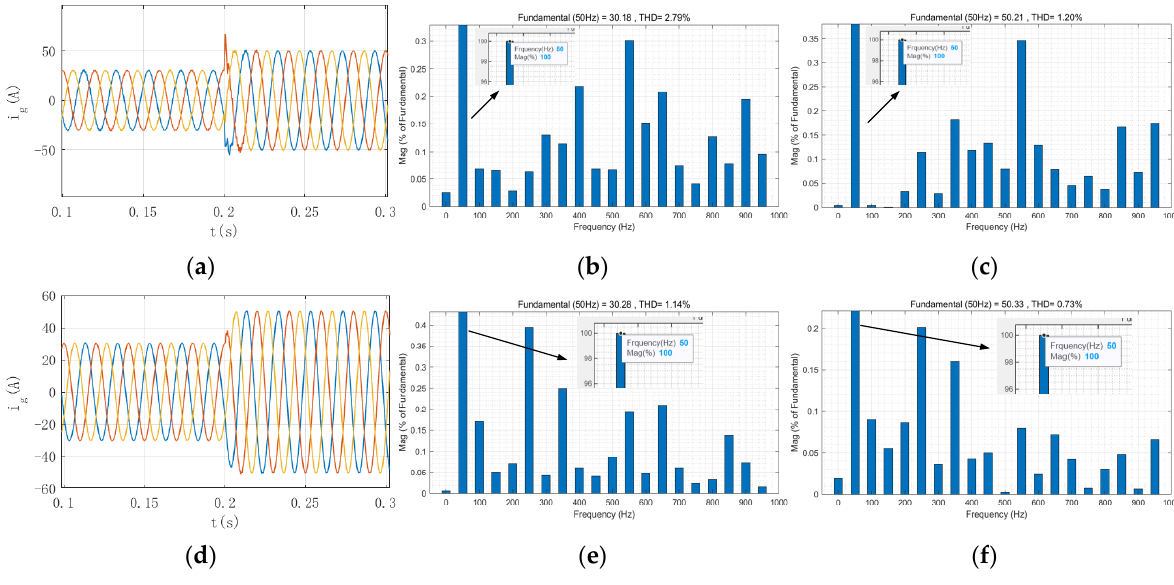
Figure 8. Comparison of grid current for PI control and LADRC control. ( a ) Grid current waveform diagram of PI Control. ( b ) THD diagram without current mutation of PI Control. ( c ) THD diagram with current mutation of PI Control. ( d ) Grid current waveform diagram of LADRC Control. ( e ) THD diagram without current mutation of LADRC Control. ( f ) THD diagram with current mutation of LADRC Control.